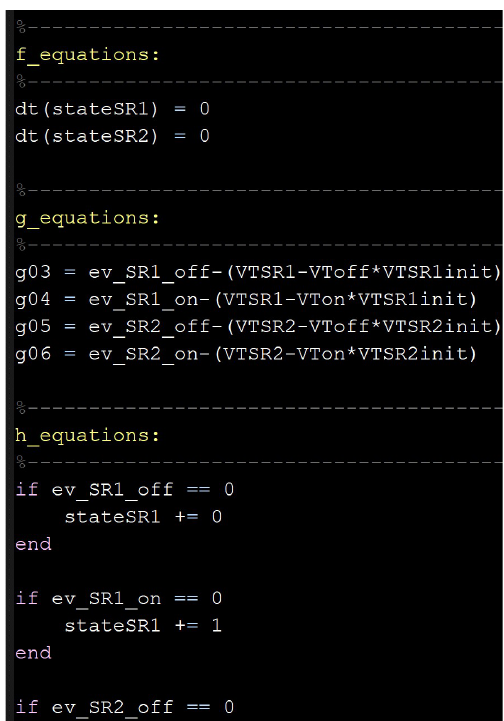
Figure 9. User-written model of the switching controller: the code implements two events for each couple of controlled shunt reactors. The events trigger respectively the switching-off and the switching-on of the reactors by considering a logical check on the bus voltage magnitude and by using discrete states change to open or to close the reactors.